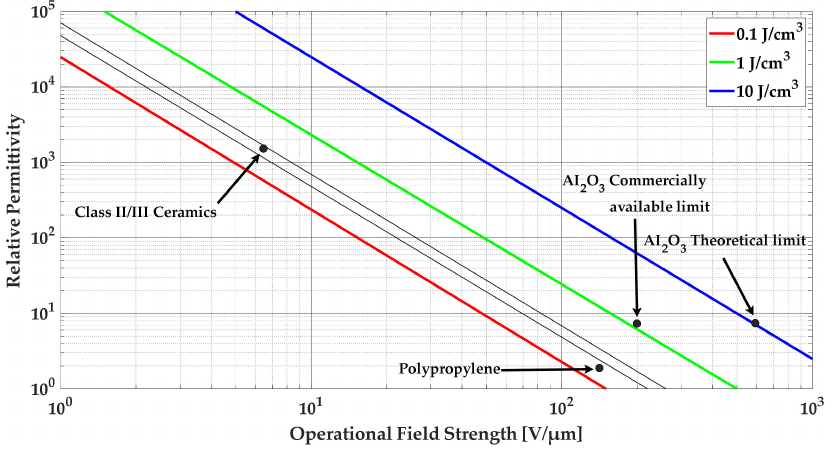
Figure 6. Energy storage density for various